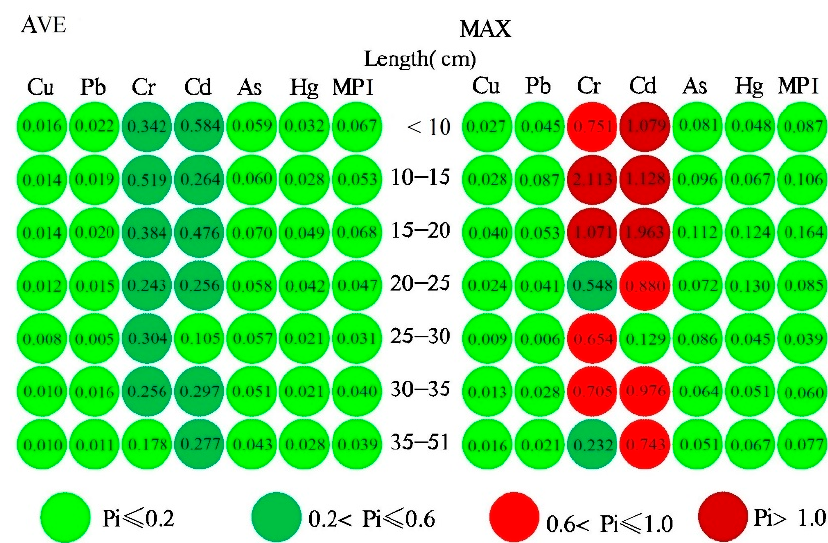
Figure 3. Pollution index (Pi) and total metal pollution index (MPI) in fish with di ff erent length ranges. According to an earlier study [9], more than half of the WFAs collected from five sampling points were contaminated by Cd and Cr to varying degrees. The wild fish with the length range of 10–20 cm accounted for 49.1 % of the total fish samples distributed in all the collection sites. In addition, the fish samples included 14 species, of which 11 species (including Pseudohemiculter dispar , Cyprinus carpio